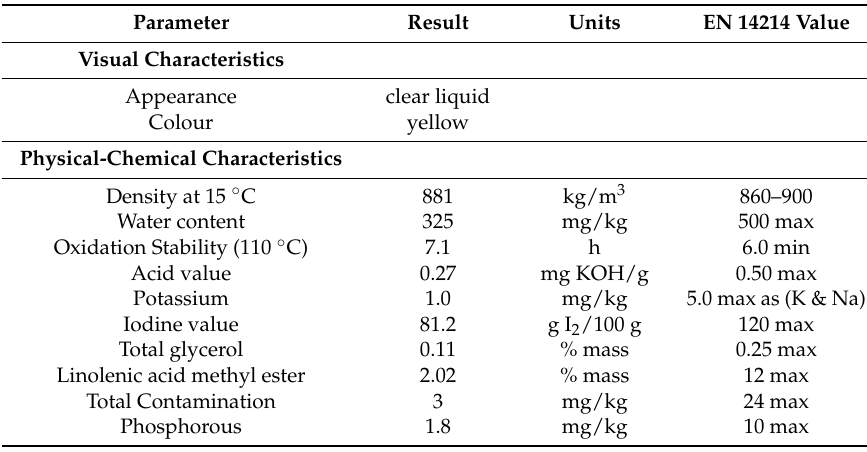
Table 1. Properties of biodiesel (B100) as provided by the manufacturing